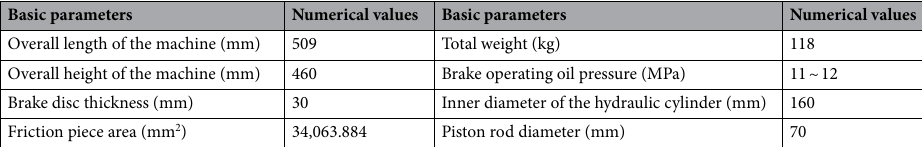
Table 1. Main parameters of the brake machine.